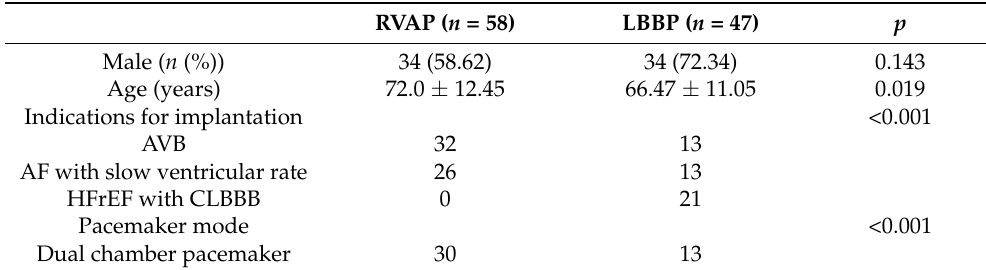
Table 1. Baseline patient characteristics according to baseline clinical, ECG pattern, and cardiac acoustic